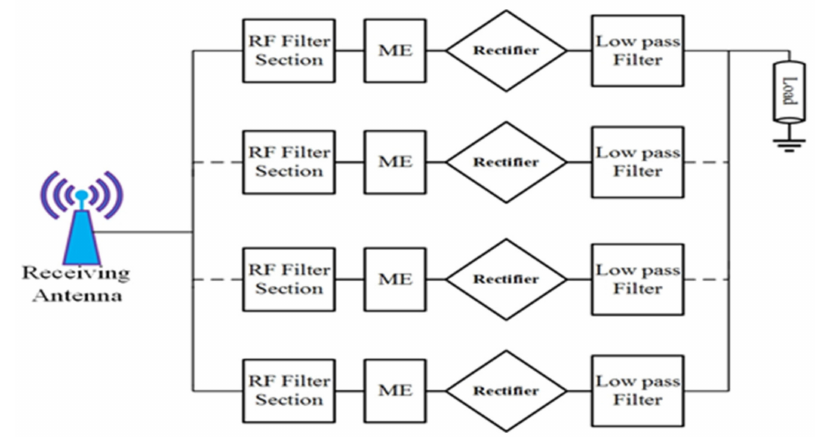
Figure 12. Proposed multiband RF harvesters topology (ME = matching